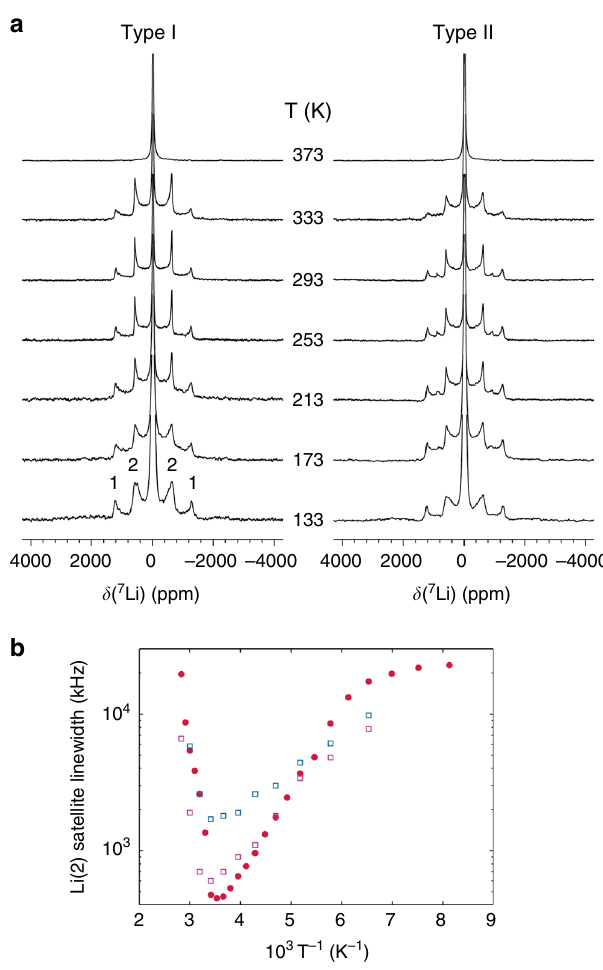
Fig. 4 7 Li NMR characterisation at variable temperatures of type I and II fi bres. a Variable-temperature (VT) wideline 7 Li NMR spectra recorded between 133 and 373 K for type I (left) and type II (right) Li 3 N nano fi bres. 1 and 2 denote satellite bands for the two-coordinate Li(1) site and three- coordinate Li(2) site, respectively; b temperature variation of the linewidth of the Li(2) satellites for type I (magenta) and II (blue) Li 3 N nano fi bres and bulk Li 3 N (red) 28 extracted from the VT NMR by fi tting a simulated powder